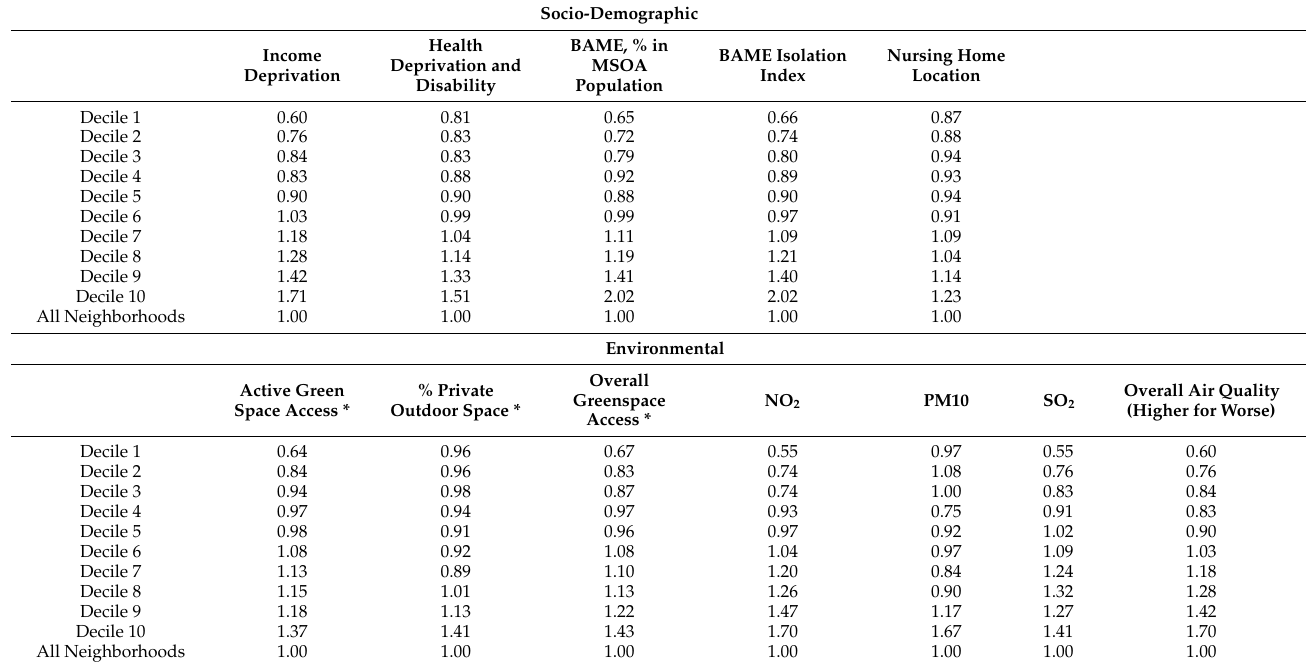
Table 2 shows SMRs by decile category for these variables. Table 2. Gradients in COVID-19 Mortality (SMRs, March–July 2020) over English